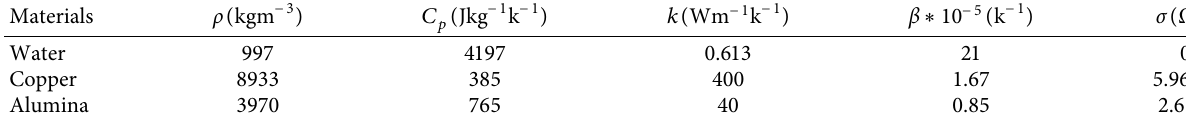
Table 1: Thermophysical properties of some base fluids and